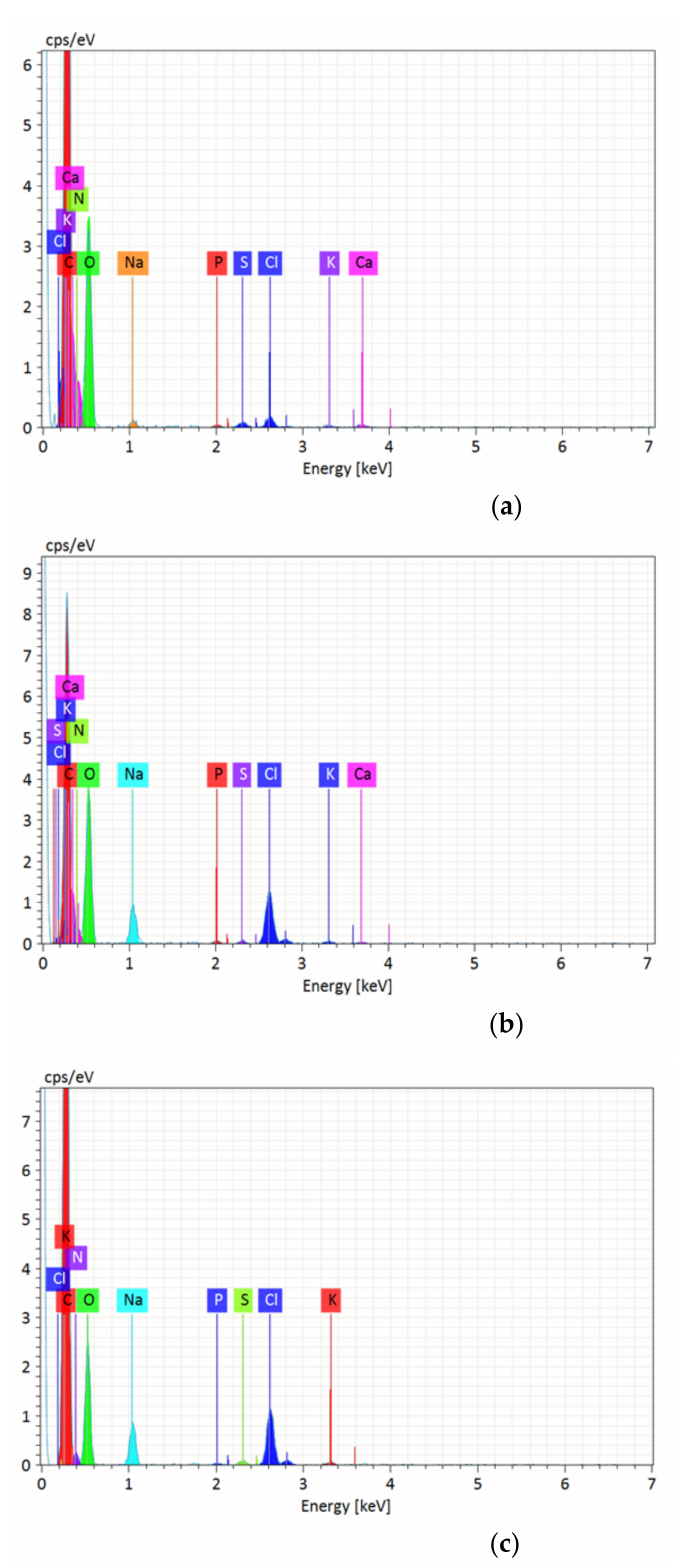
Figure 5. TEM analysis of the composites to determine their chemical composition: ( a ) graph depicting data for composite H0; ( b ) graph depicting data for composite HA; ( c ) graph depicting data for composite